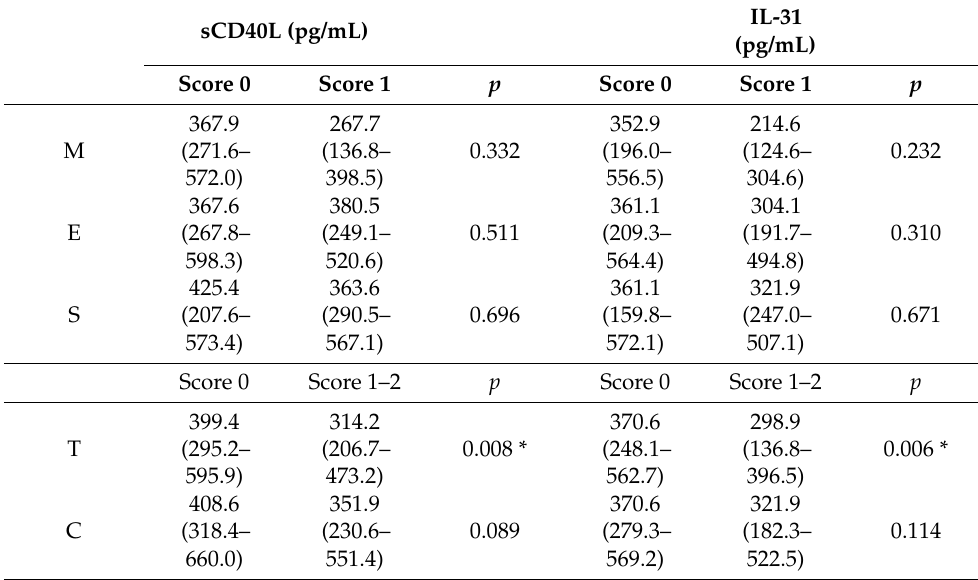
Table 6. Serum levels of cytokines according to the Oxford classification of